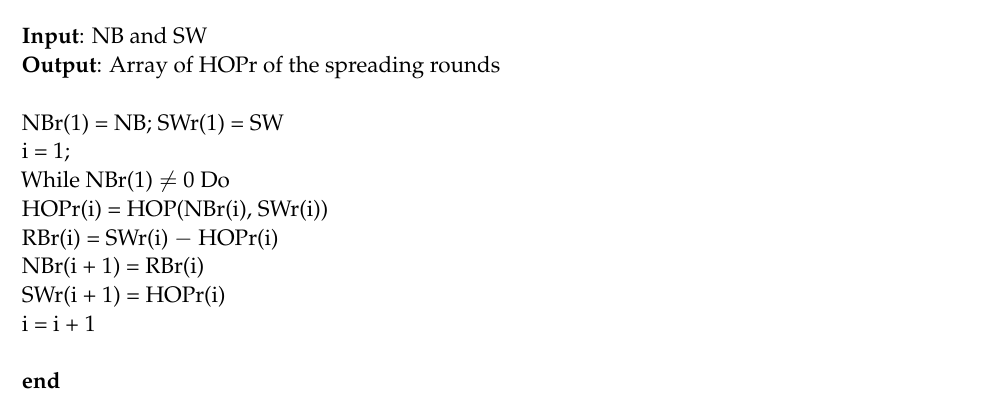
Algorithm 1 . The Imbrical Spreading Function Algorithm